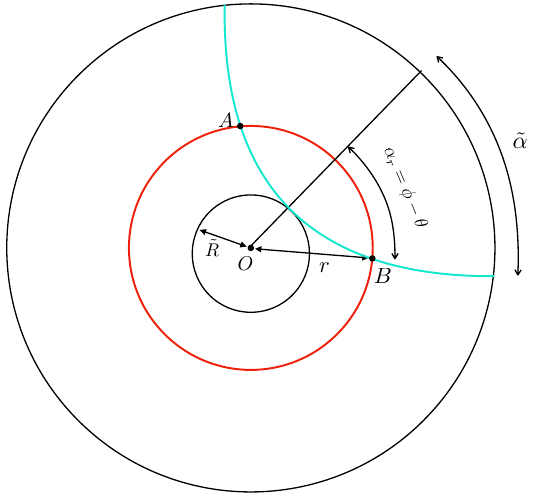
Figure 5 . A spacelike geodesic (in turquoise) at a time slice in conical or pure AdS centered at boundary angular coordinate θ and with a boundary opening angle ˜ α . The geodesic is by construction tangent to a bulk disk of radius ˜ R . The geodesic distance between points A and B , which both lie on a circle (in red) of radius r , is computed in appendix